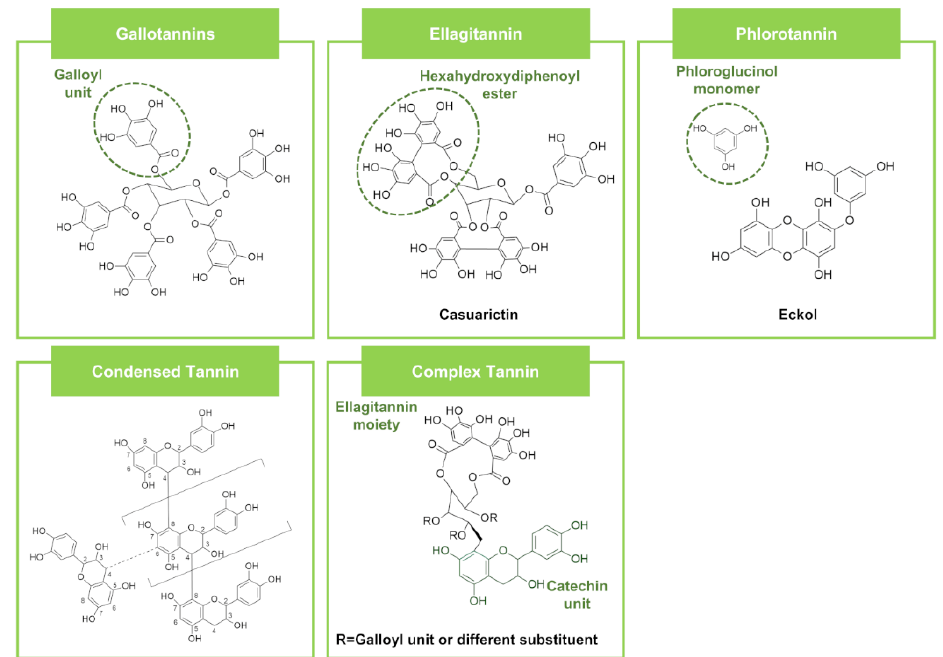
Figure 4. Representative chemical structures of different classes of